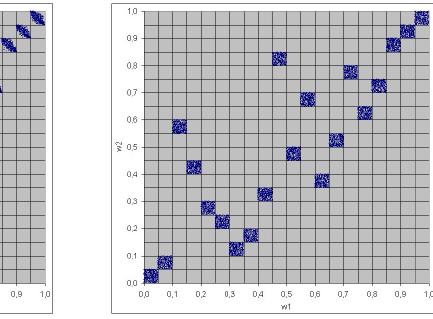
Figure 15: Normal copula driver, ρ = −0.8